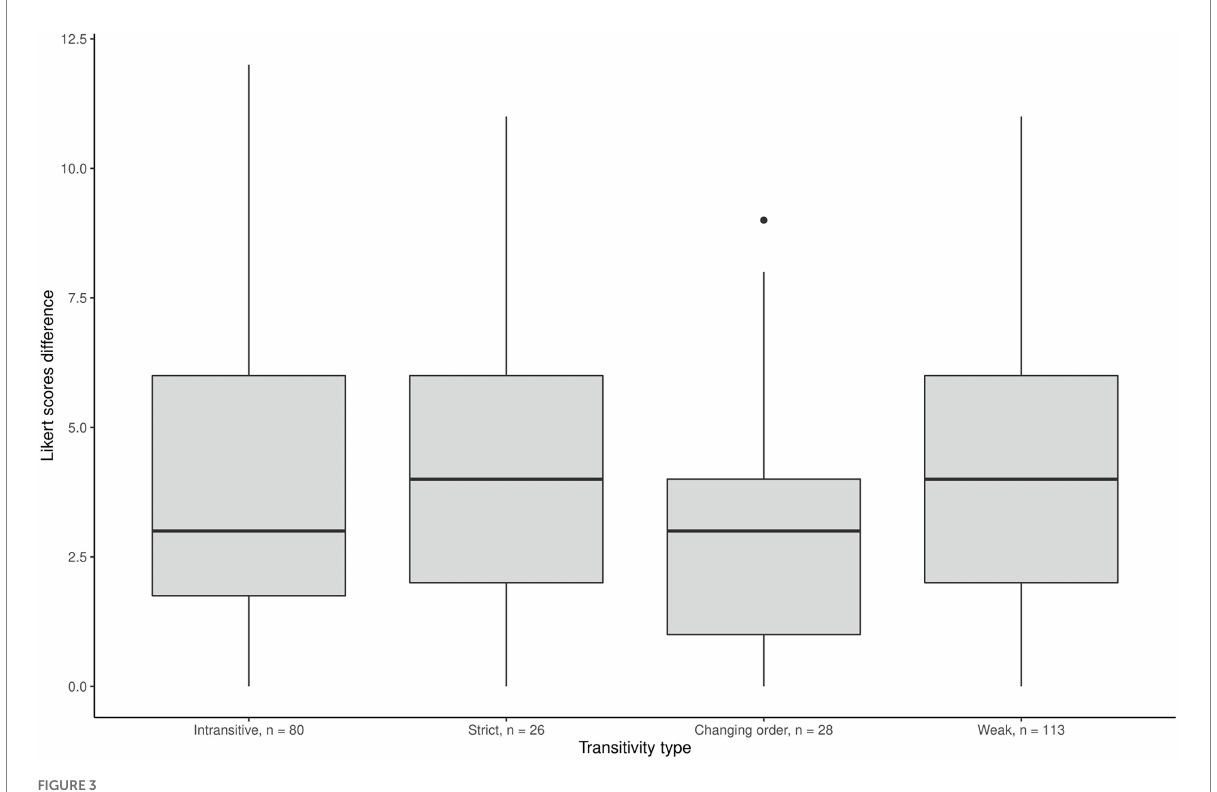
FIGURE 3 Mean difference in Likert scores between external motivation and amotivation